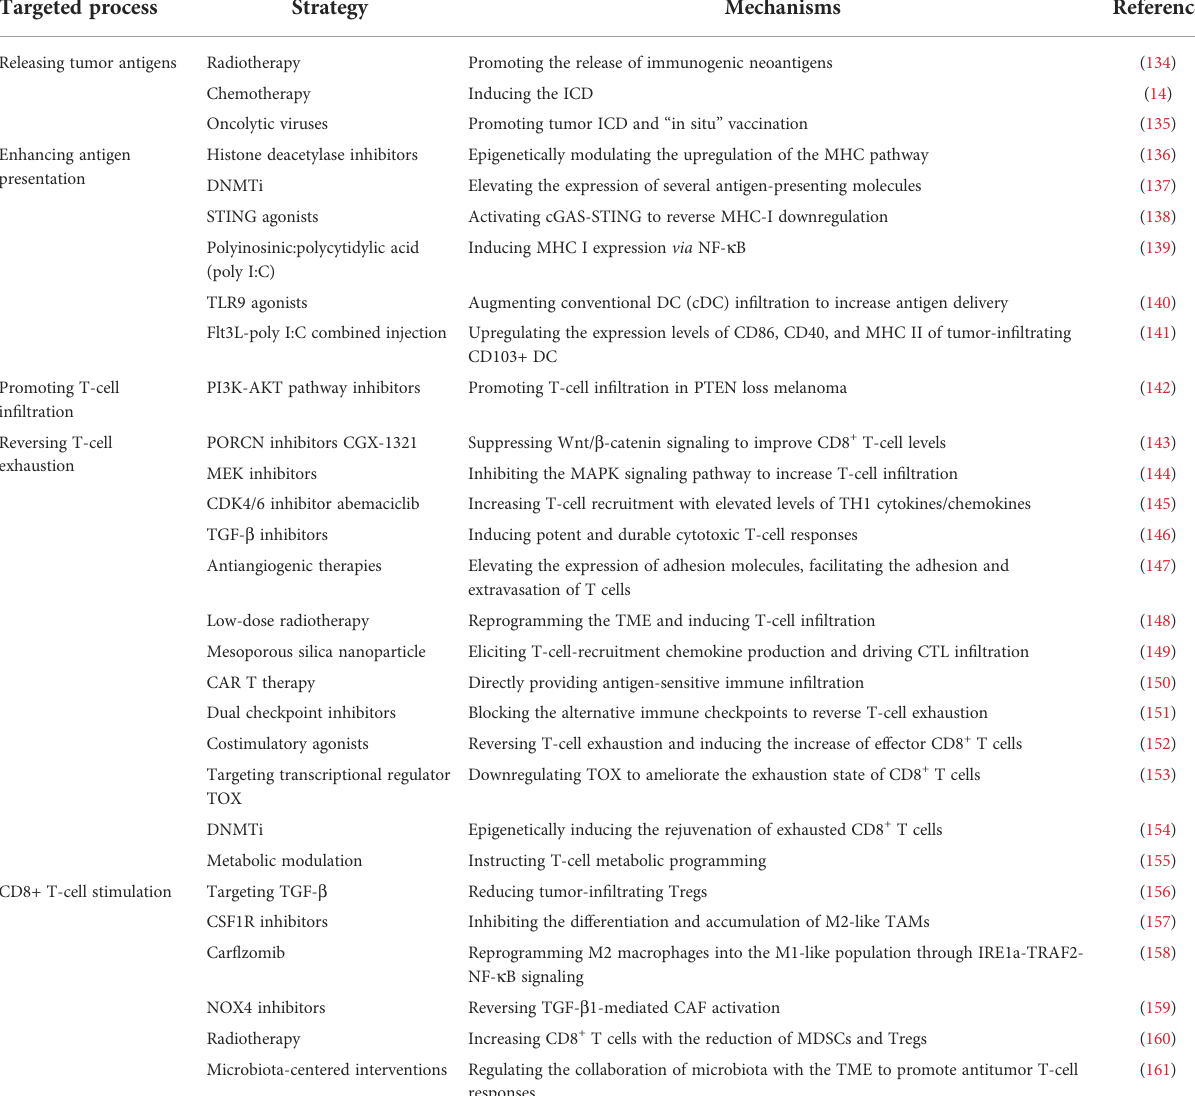
TABLE 1 Potential combination strategies to improve the antitumor effect of programmed cell death protein 1 (PD-1)/programmed cell death ligand 1 blockade. Targeted process Strategy